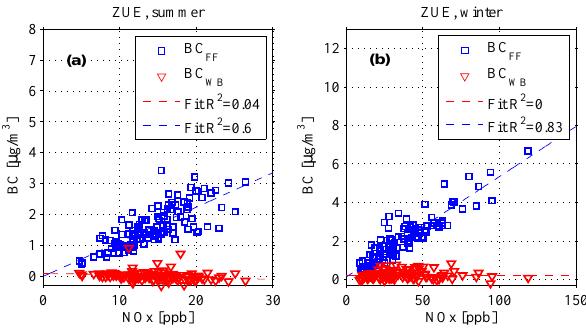
Fig. 7. Scatter plot of daily BC (BC FF and BC WB ) and NO x for ZUE for summer (a) and winter (b) . Both plots include linear re- gression